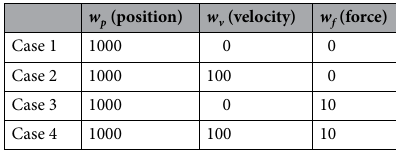
Table 3. Cost weight